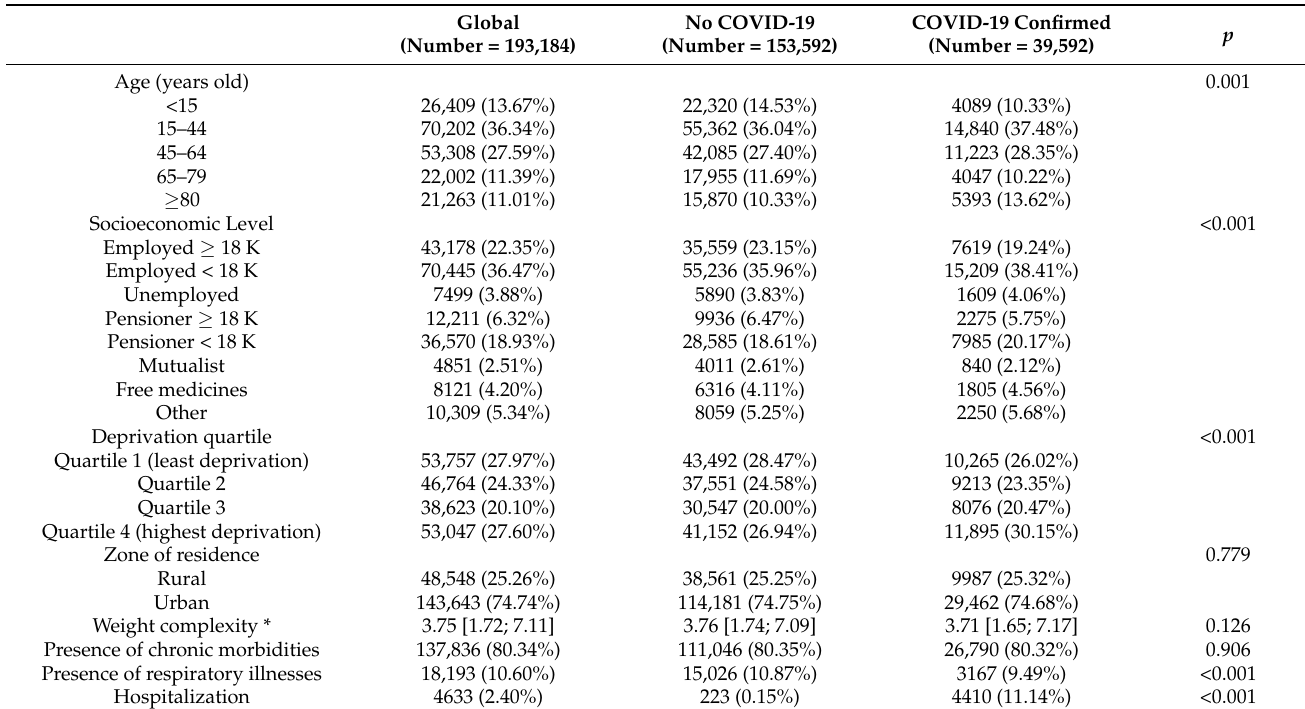
Table A2. Sociodemographic and morbidity description of women tested for COVID-19 for the whole period analyzed.